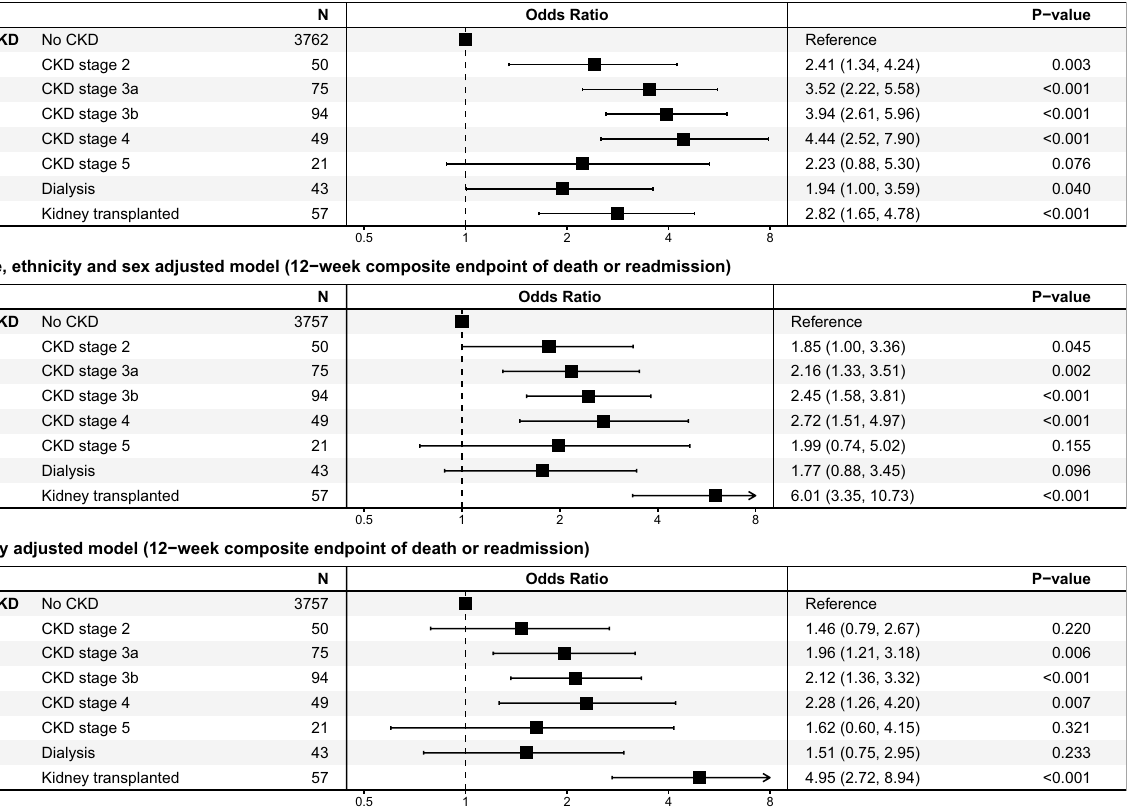
Figure 1. ( a – c ) Unadjusted; age, sex and ethnicity adjusted; and fully adjusted 12-week mortality and readmission odds ratios in patients hospitalized for COVID-19 among CKD groups compared to “no-CKD” with corresponding P values. CKD stage 2 = eGFR 60–79 ml/min/1.73 m 2 , CKD stage 3a = eGFR 45–59 ml/ min/1.73 m 2 , CKD stage 3b = eGFR 30–44 ml/min/1.73 m 2 , CKD stage 4 = eGFR 15–29 ml/min/1.73 m 2 , CKD stage 5 = eGFR < 15 ml/min/1.73 m 2 , CKD = chronic kidney disease. P is considered significant at P ≤